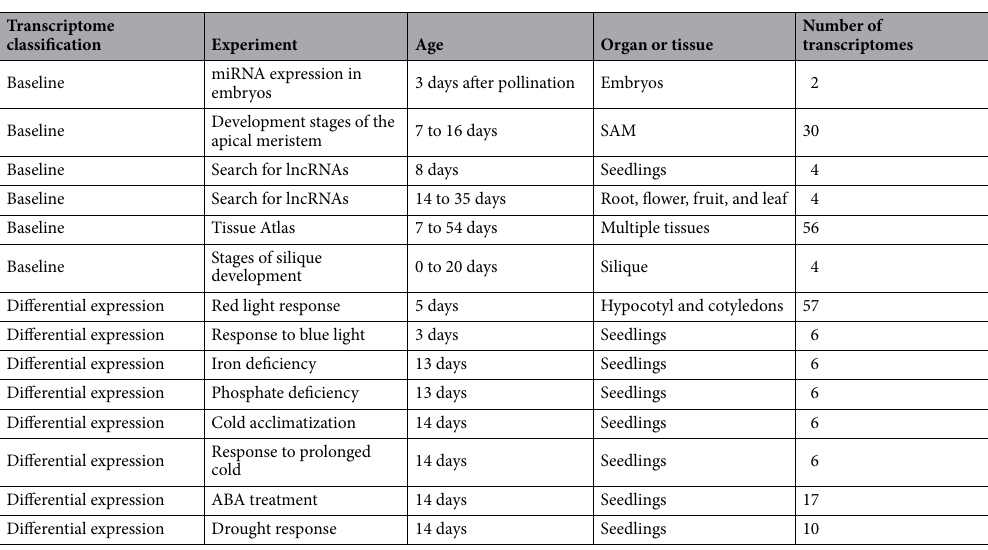
Table 1. Summary of transcriptomes used for lncRNA